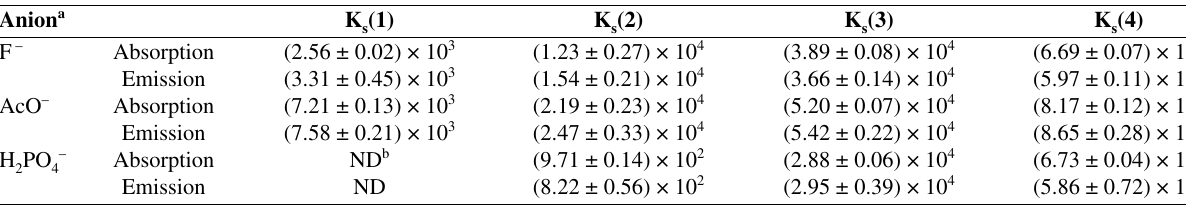
Table 1. Affinity constants of compounds with various anions Anion